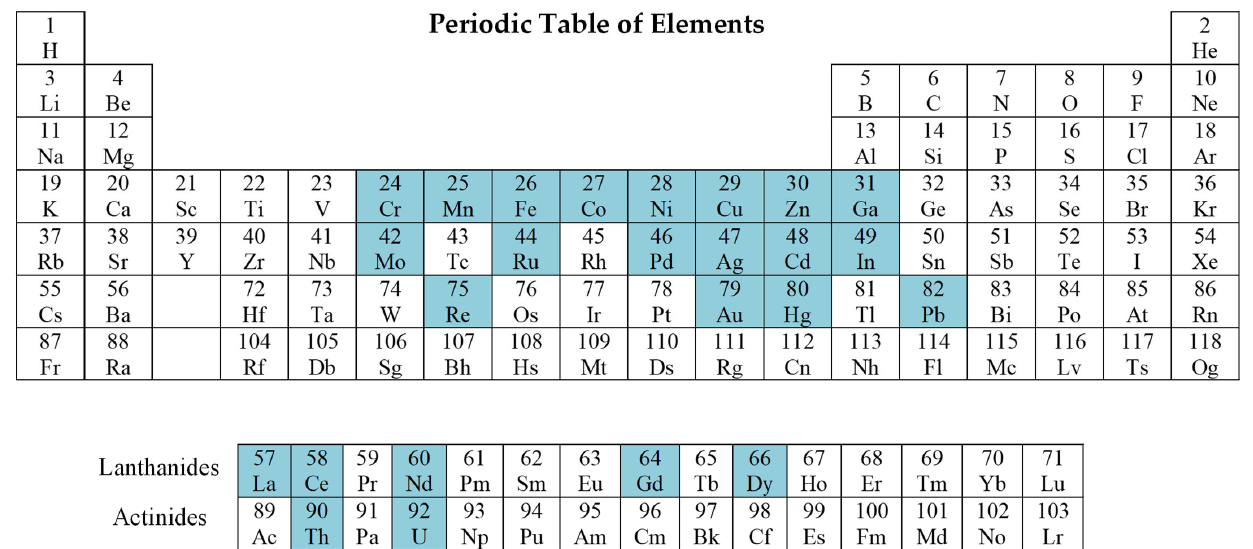
Figure 3. Periodic table of elements. The target metal ions discussed in this work are highlighted in blue.